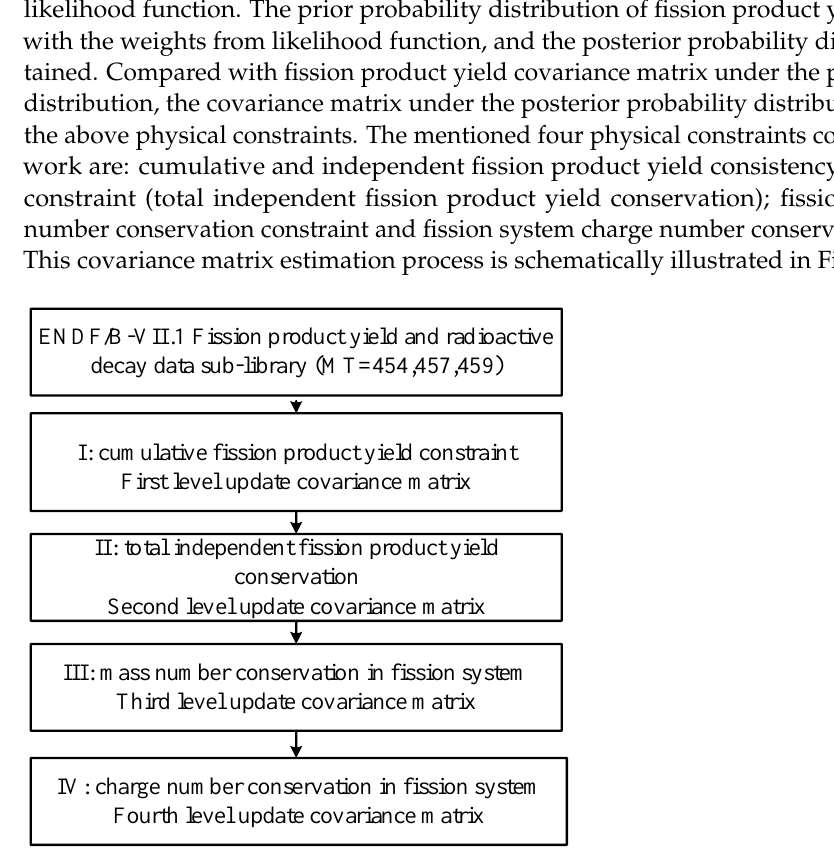
Figure 1. Schematic illustration of independent fission product yield covariance estimation. In Figure 2, each element is the correlation coefficient between independent fission product yields from the 239 Pu thermal neutron induced fission system. The correlation coefficient has its absolute value larger than 0.01, as shown in Figure 2. The blue plots are negative correlation coefficients between the fission product yields and the red plots represent the positive correlations. The correlation coefficient ρ ( y i , y j ) between independent fission product yield y i and y j is calculated as in Equation (1). Here, cov ( y i , y j ) is the covari- ance between y i and y j , while σ ( y i ) and σ ( y j ) are their standard deviations, respectively.